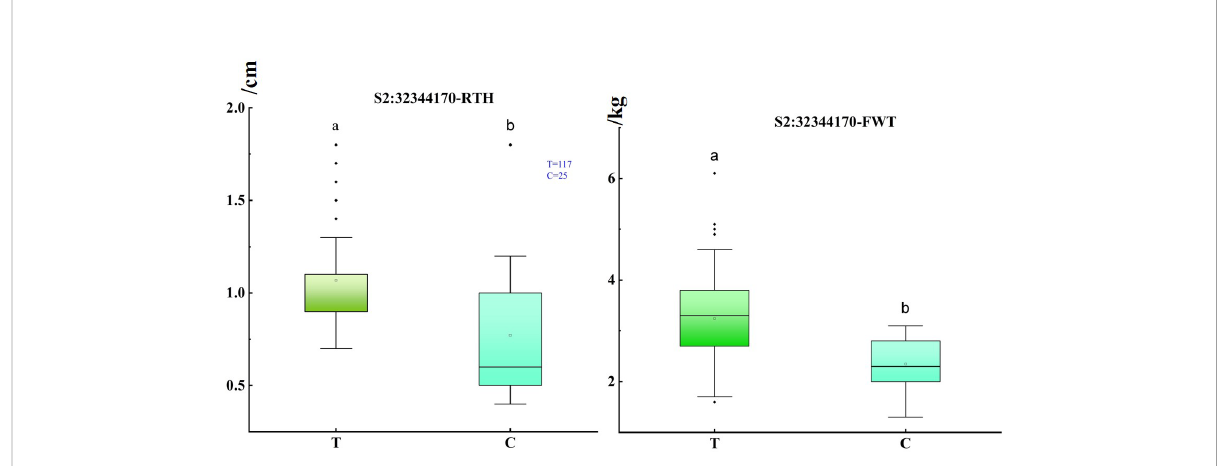
FIGURE 3 Box plot of single fruit weight and rind thickness under different bases of S2: 32344170. The abscissa represents the alleles with a mutation at the locus, the reference base near the origin, the other one was the key mutation locus, and the ordinate represents the rind thickness and fruit weight, respectively. Signi fi cance level: 0.05, a, and b represented signi fi cant differences in rind thickness under different alleles. The hollow origin in the boxplot represents the mean